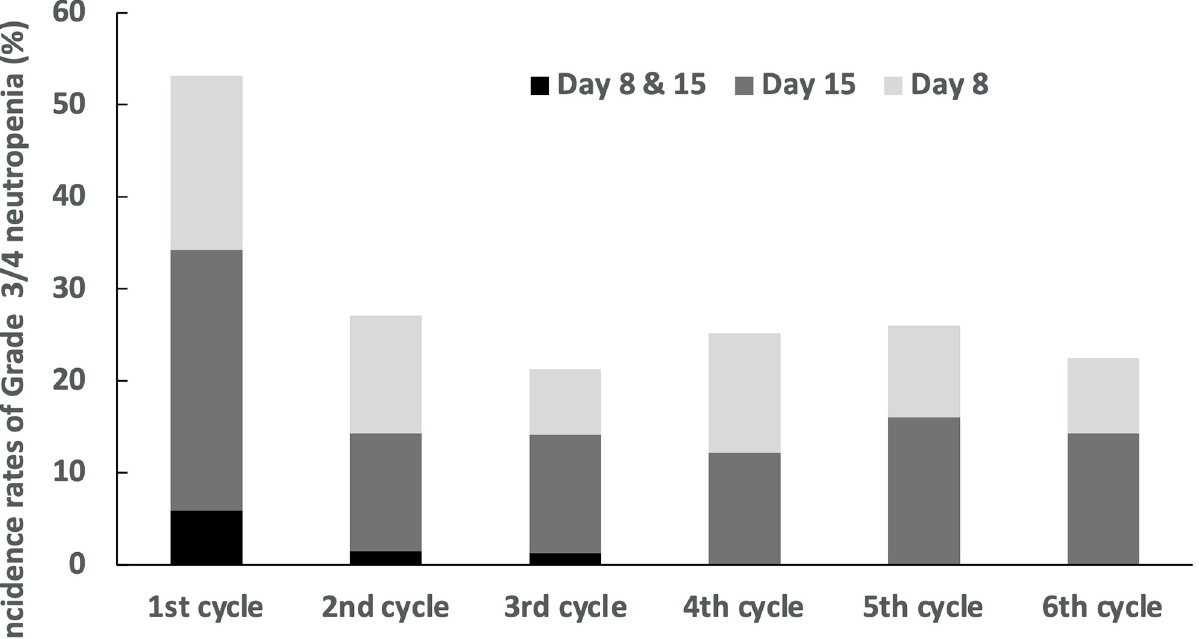
Fig 2. Incidence of neutropenia Grade 3/4 in each treatment cycle from 1 to 6. Day 8&15 (Black): Neutropenia developed on Day 8 and the drug was discontinued, but Grade 3 or higher neutropenia continued until Day 15. Day 15 (Dark gray): Neutropenia was absent on Day 8 but developed on Day 15 and the drug was discontinued. Day 8 (Light gray): Neutropenia developed on Day 8 and the drug was discontinued, but it was reinstated on Day 15.